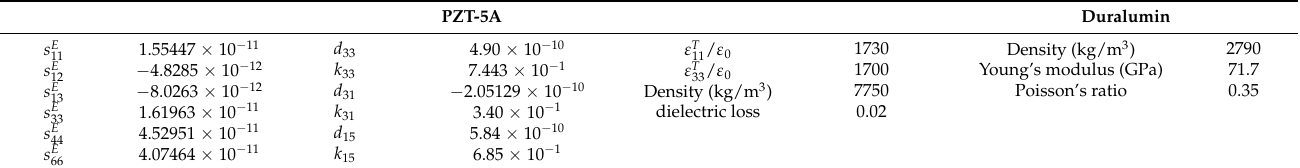
Table 1. Material parameters of piezoelectric oscillator.